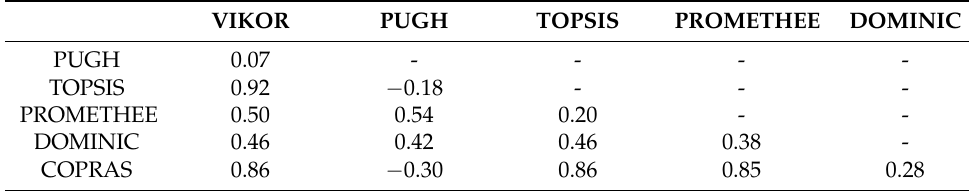
Table 25. Spearman correlation in MCDM